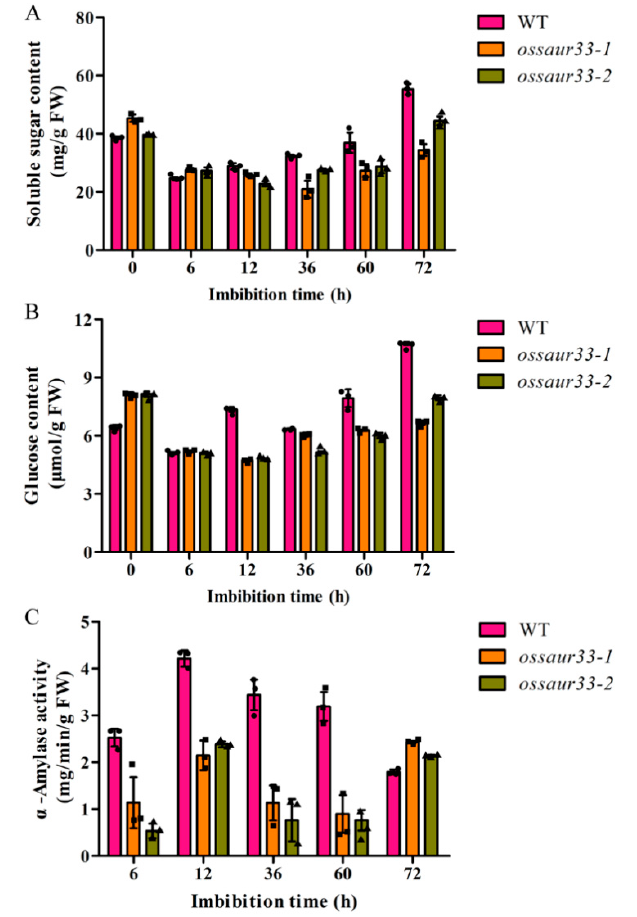
Figure 5. OsSAUR33 regulates sugar levels during seed germination in rice. ( A ) Total soluble sugar; ( B ) Glucose; ( C ) α -amylase activity. Each column represents the mean ± standard deviation, black small symbol means the value of each replication, n = 3.